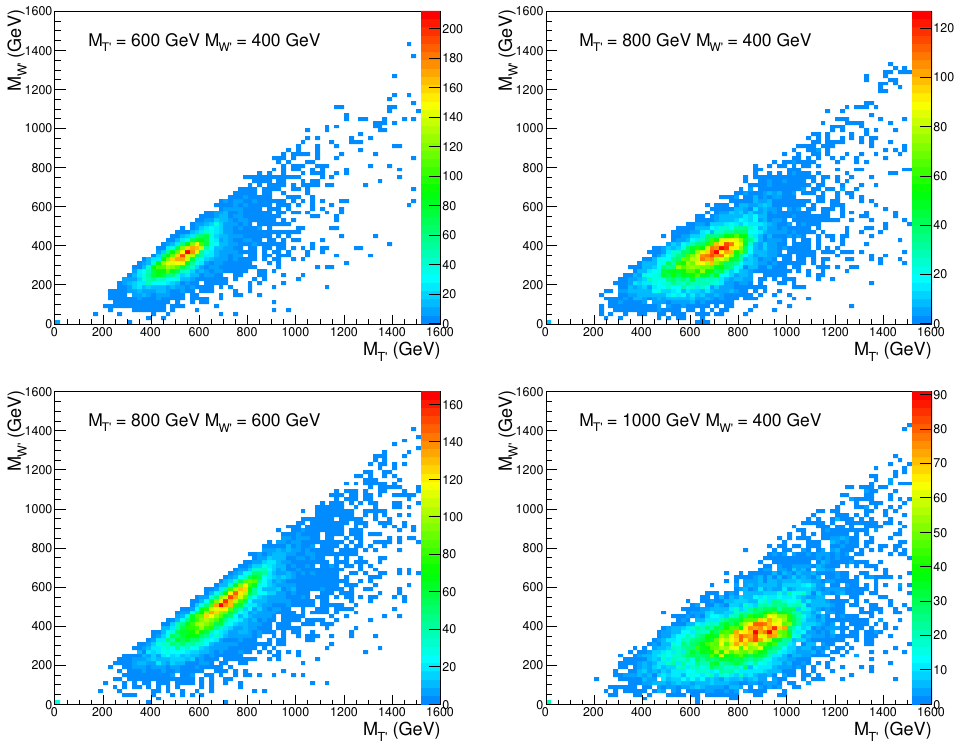
Figure 7 . Reconstructed signal distributions (littlest Higgs model) for M T 0 = 600 GeV, M W 0 = 400 GeV (top left), M T 0 = 800 GeV, M W 0 = 400 GeV (top right), M T 0 = 800 GeV, M W 0 = 600 GeV (bottom left) as well as M T 0 = 1000 GeV, M W 0 = 400 GeV (bottom